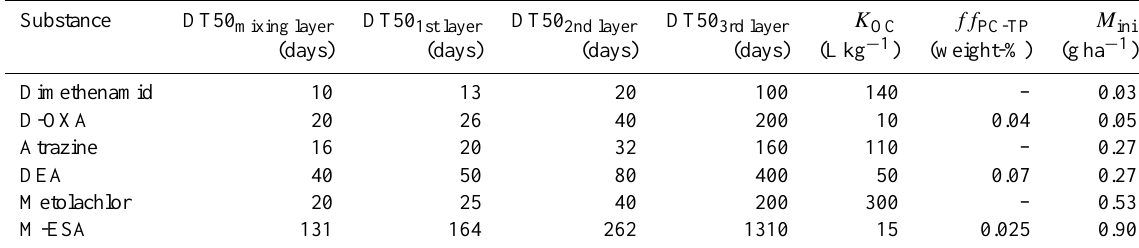
Table 2. Calibrated chemical model parameter values. M ini is the initial soil concentration of substances.